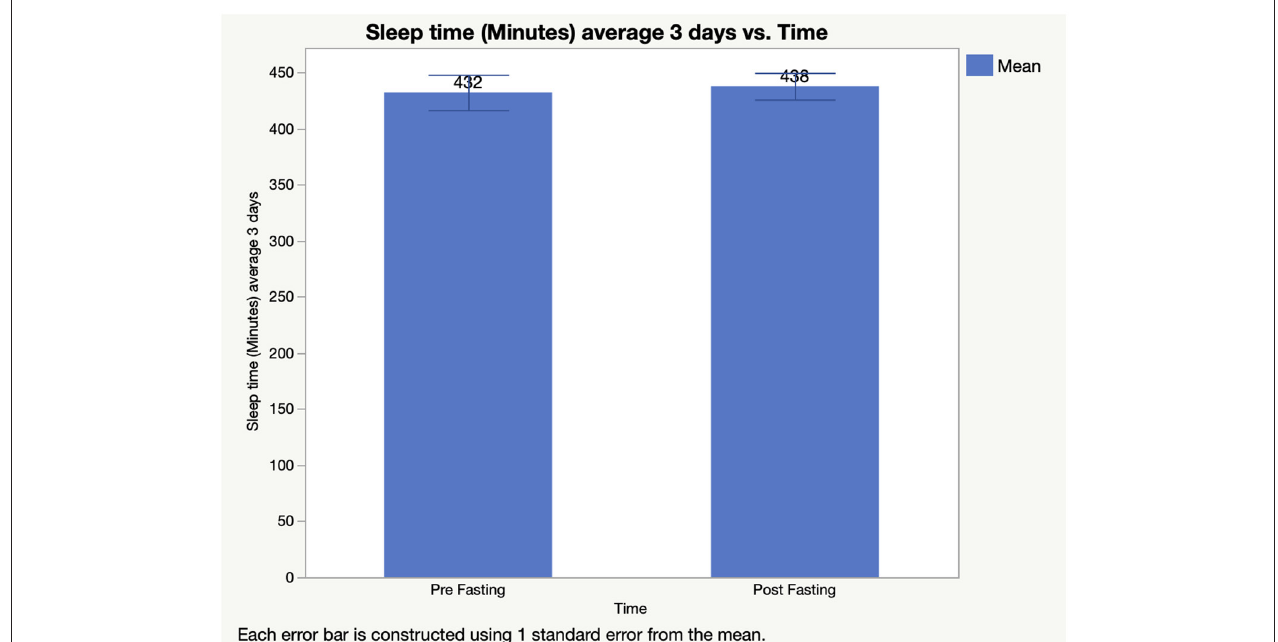
FIGURE 2 | Sleeping Duration Before and During Ramadan